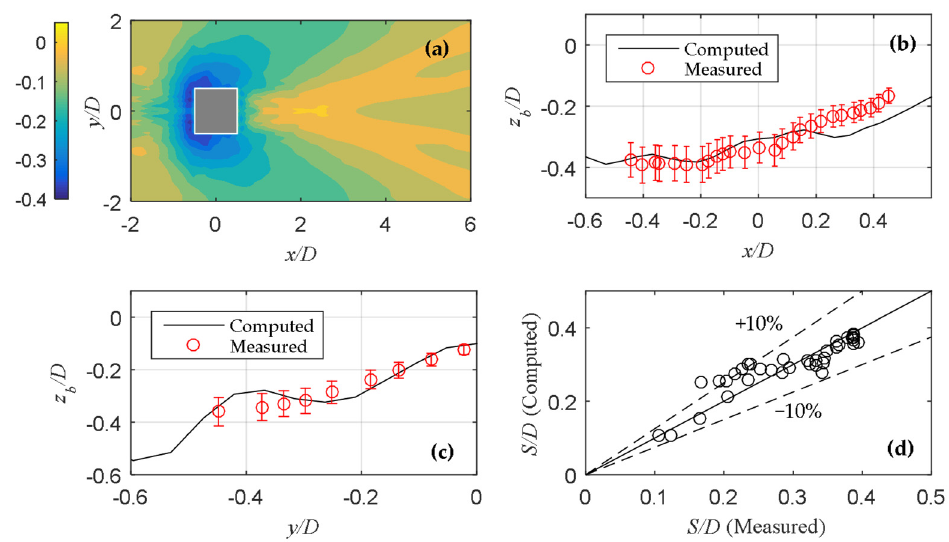
Figure 4. Comparisons of local scour around structure between CFD simulated and experimental measured results: ( a ) final bed elevation contour; ( b ) final scour bed profile along longitudinal direction; ( c ) final scour bed profile along transverse direction; ( d ) comparison between computed and measured scour depth.